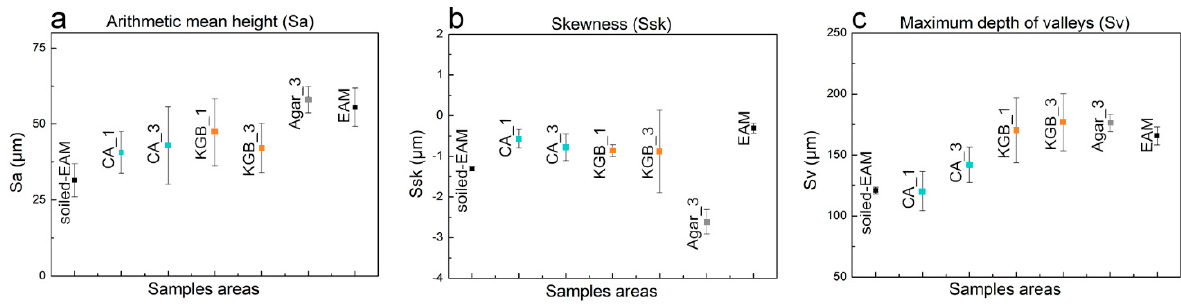
Figure 8. Images by stereomicroscope of the soiled-EAM cleaned by CA gel and KGB gel at different application times CA_1 ( a ), CA_3 ( b ), KGB_1 ( c ), and KGB_3 ( d ).